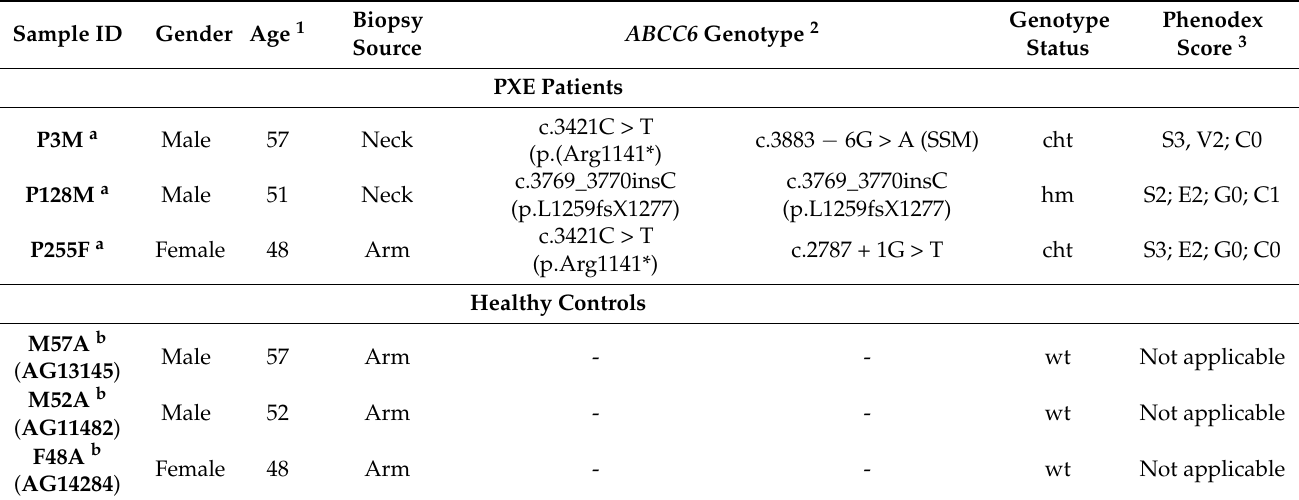
Table 1. Characteristics of fibroblasts